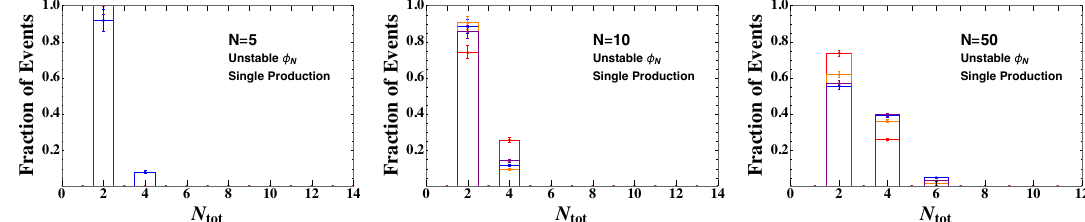
Figure 8. Total number of particles in the event in the Z in eqs. (3.1) and (3.2). Final state particles include two stable scalars. Di(cid:11)erent colors correspond to di(cid:11)erent spectra. From left to right: N =5, 10, and 50 scalars in the new sector.